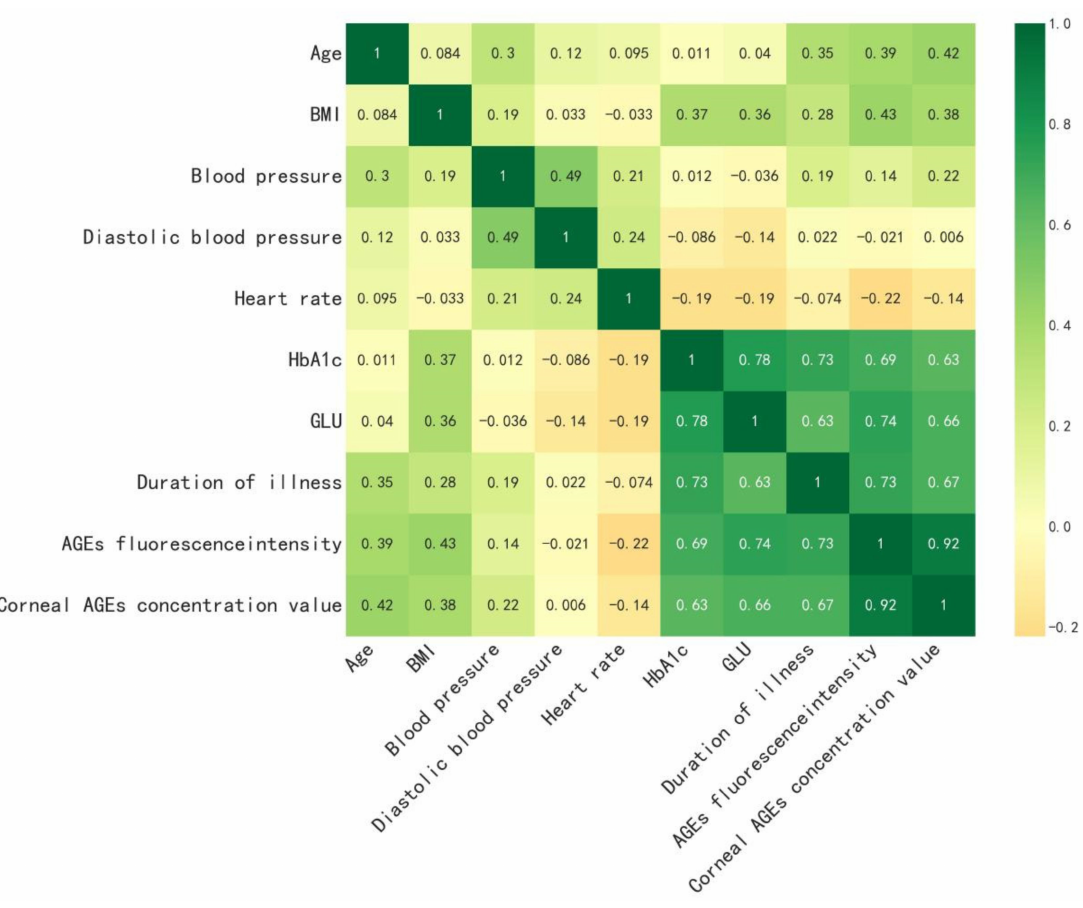
Figure 4. Correlation matrix